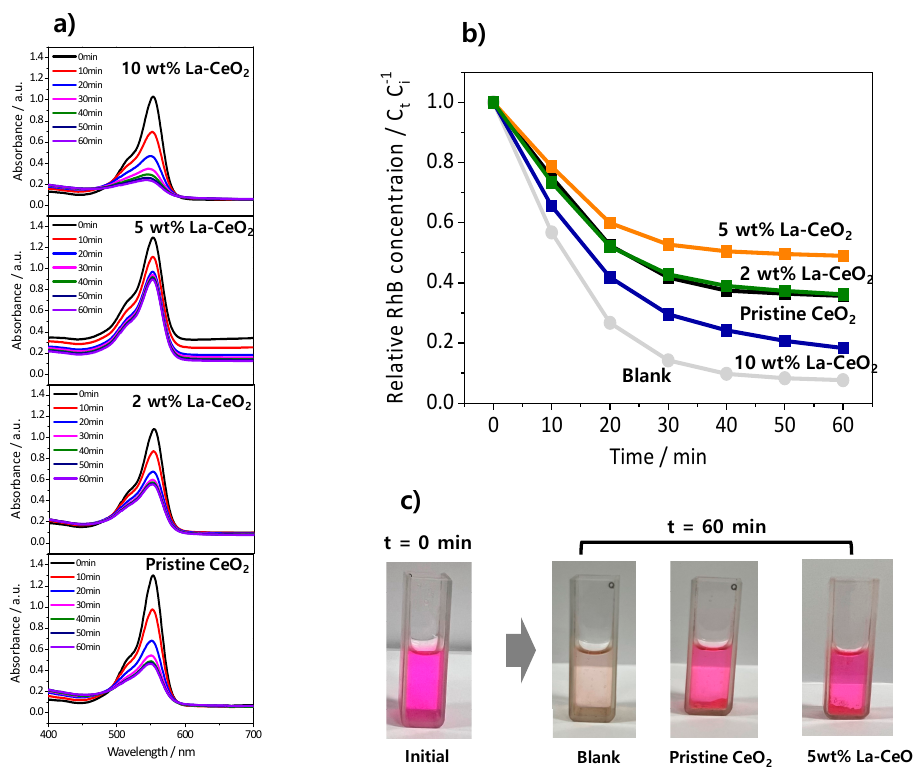
Figure 4. ( a ) UV spectra of the Fenton’s solutions with RhB and the radical scavengers added. ( b ) Relative RhB concentration in the solution over time after adding radical scavenger in the solution. ( c ) Photograph of the solution before and after the radical scavenging test.